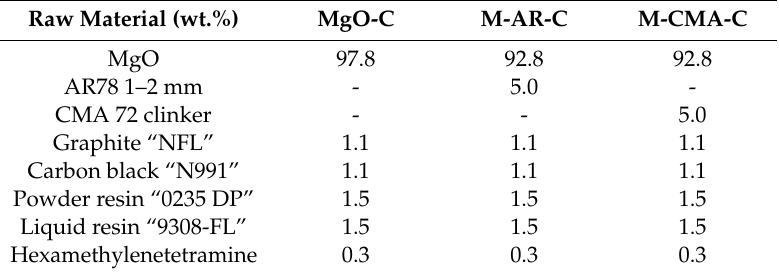
Table 2. Sample composition.